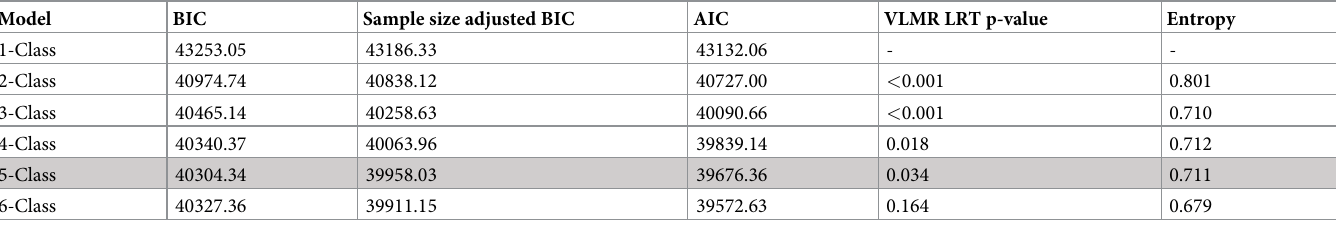
Table 2. Comparisons of fit statistics of the LCA models used to select classes (N =